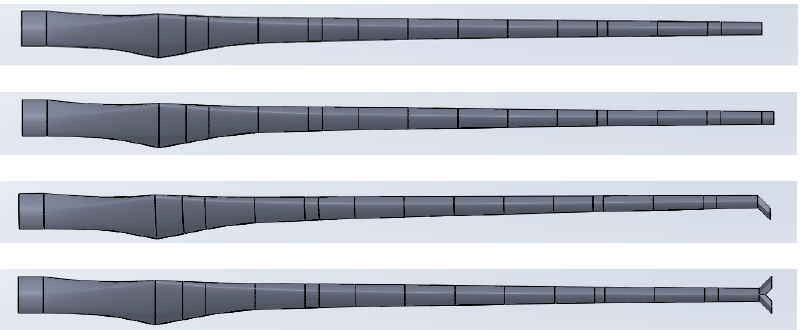
Figure 3. Top to bottom: NREL Phase VI Seq. H blade, NREL Phase VI Seq. H blade with 1.5% extension, extension with 45° offset to suction side to create a winglet and extension with 45° offset to both the suction and pressure side to create a split winglet.